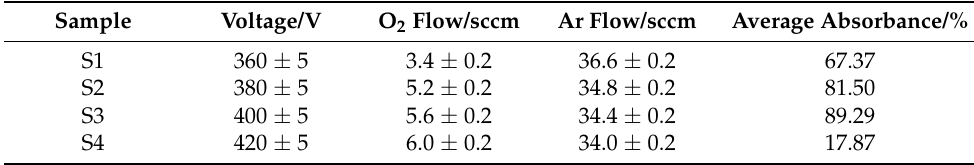
Table 1. The sputtering parameters and the average optical absorbance of Samples S1, S2, S3, and S4 from 250 to 800